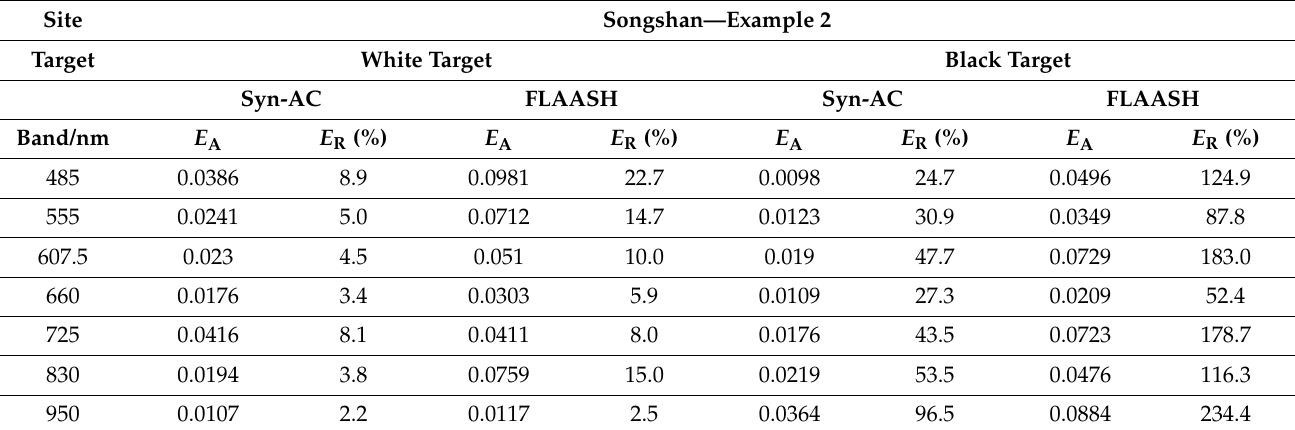
Table 9. Performance comparison between Syn-AC and FLAASH, basing on Example